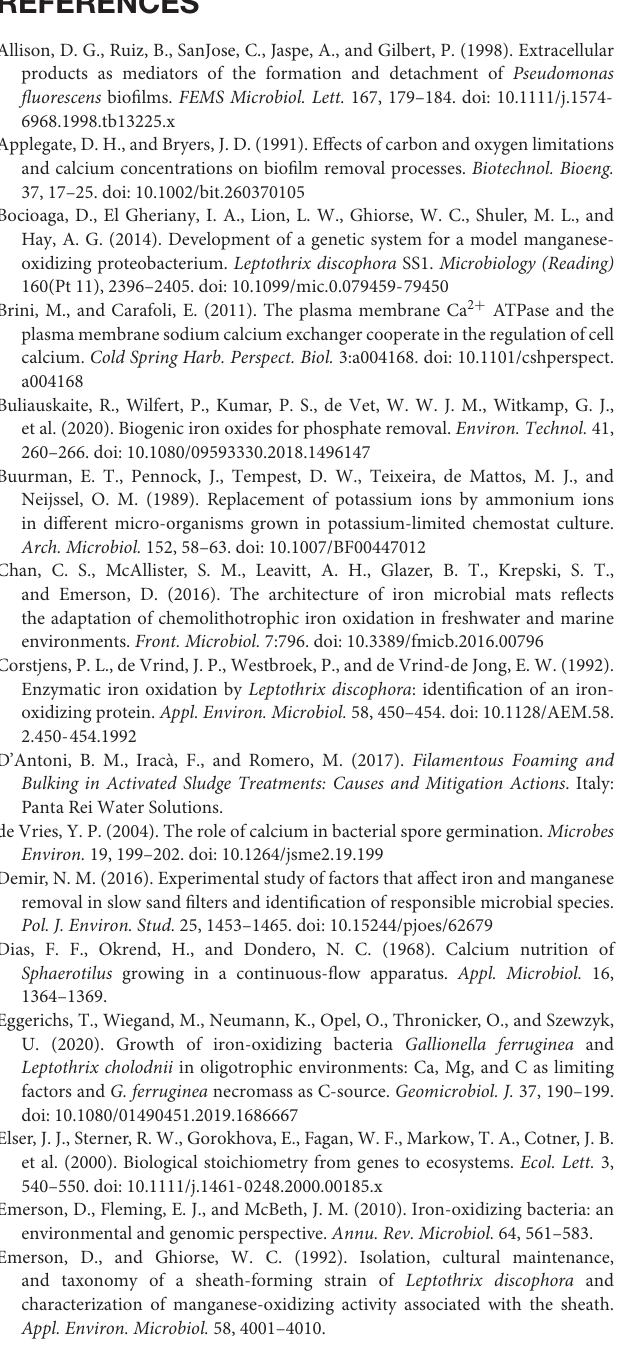
Supplementary Movie 9 | Time-lapse video of SP-6 cells cultured in MSVP-Mg (mp4). Supplementary Movie 10 | Time-lapse video of SP-6 cells cultured in MSVP-Ca (mp4). Supplementary Movie 11 | Time-lapse video of SP-6 cells before (A) and after (B) the addition of EGTA to the original MSVP during culturing (mp4).